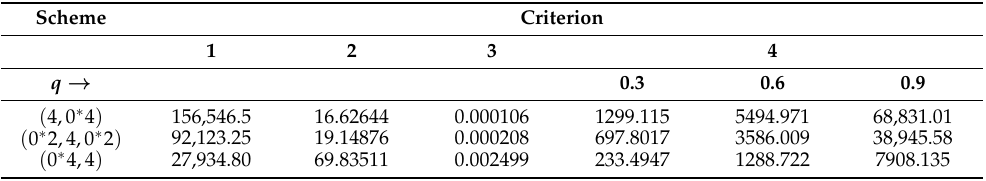
Figure 11. The log-likelihood functions of α and δ using scheme ( 4,0 ∗ 4 ) for electronic devices data. Table 14. Optimal progressive censoring from electronic devices